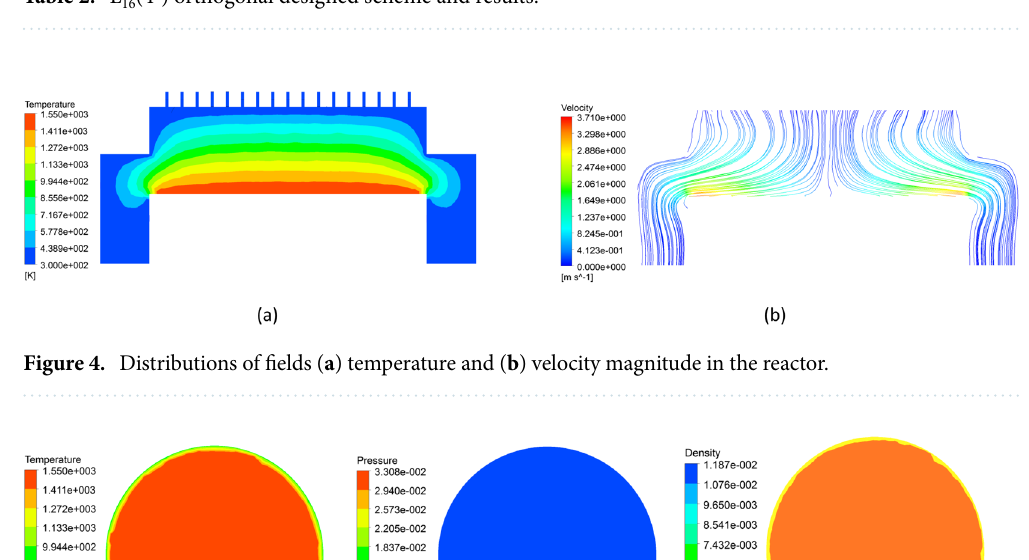
Table 2. L 16 (4 4 ) orthogonal designed scheme and results.